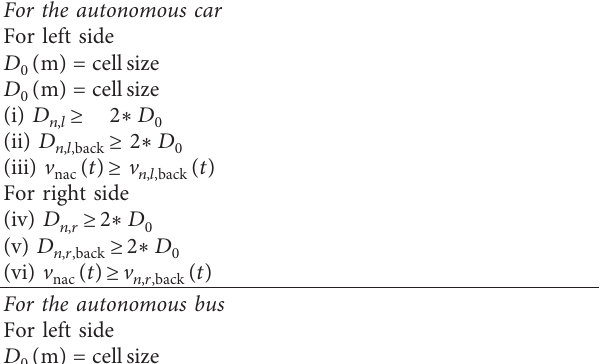
Table 6: Aggressive lane change rules. For the autonomous car For left side